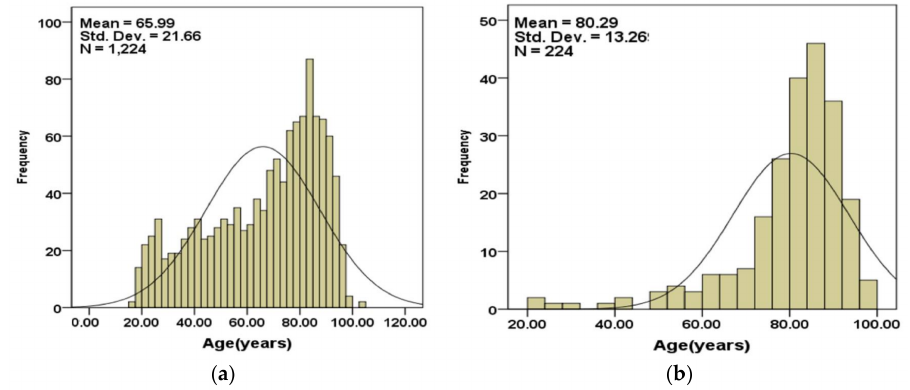
Figure 2. ( a ) Age distributions of the subjects in the validation set for the cases that ( a ) survived and ( b ) had not